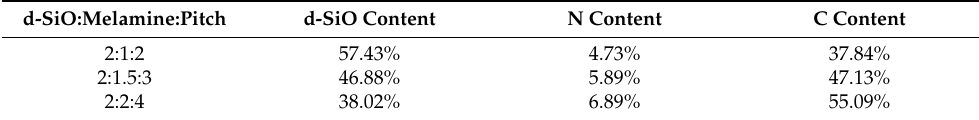
Table 1. The content of d-SiO, N and C in three kinds of prepared d-SiO-NC